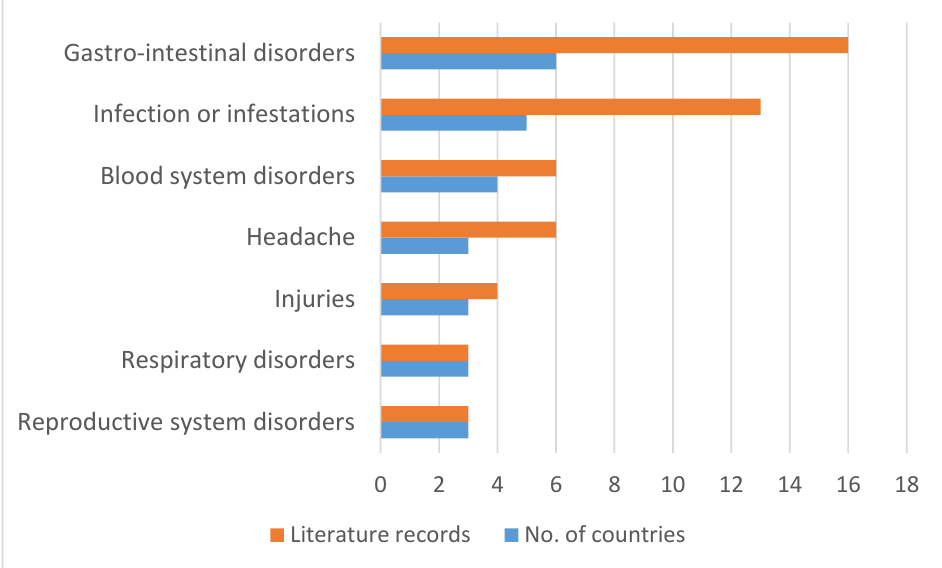
Figure 4. Major diseases treated by Lannea schweinfurthii extracts in south, central and east Africa.